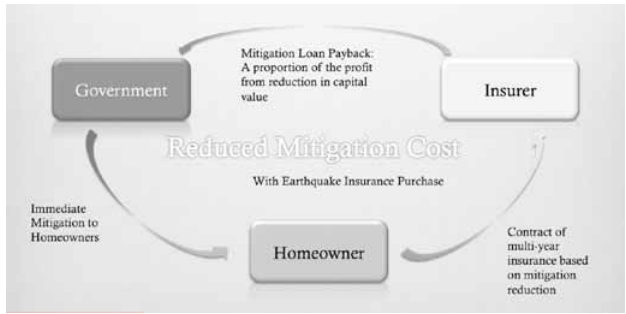
Fig. 1. PPP framework for seismic